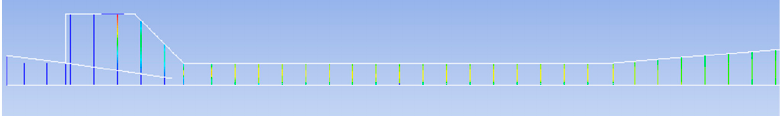
Figure 14. Impacts of ejector outlet pressure on removal of CO 2 (d nozzle = 6 mm-Q L = 2.85 × 10 − 4 m 3 /s, [MEA] = 30%Wt).